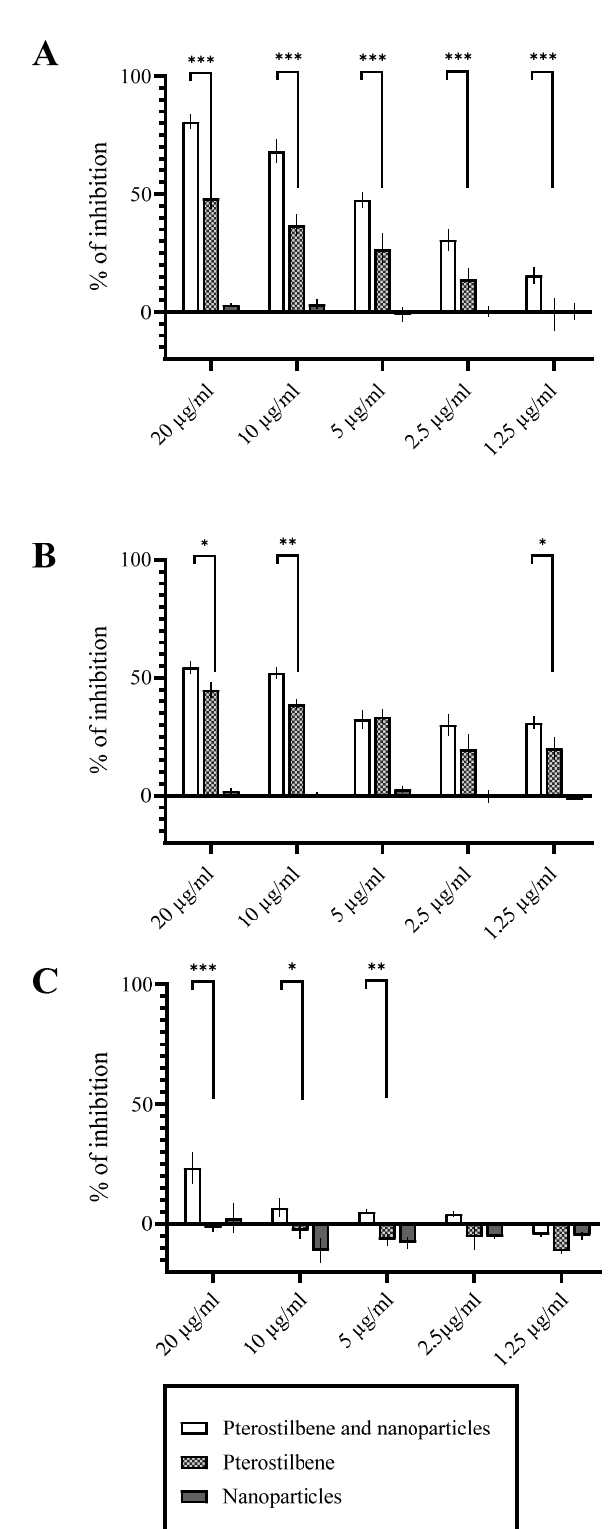
Figure 4. Activity of free PTB and PLGA-PTB-NPs against A. brasiliensis (DSM 1988). Activity of free PTB and PLGA-PTB-NPs against A. brasiliensis biofilm in formation, after 24 h of incubation ( A ). Activity of free PTB and PLGA-PTB-NPs against A. brasiliensis 24 h biofilm, after 24 h of incubation ( B ). Activity of free PTB and PLGA-PTB-NPs against 48 h biofilm, after 24 h of incubation ( C ). * p < 0.05 compared to the control; ** p < 0.01 compared to the control *** p < 0.001 compared to the